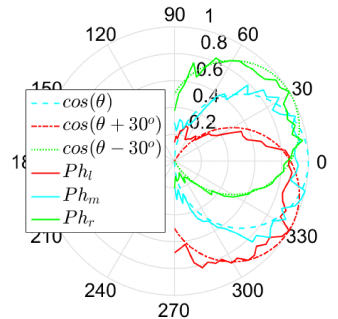
Figure 3. Sensor characterization and comparison between the theoretical (dotted lines) and measured angular sensitivities (continuous lines) of the photodiodes plotted here in polar